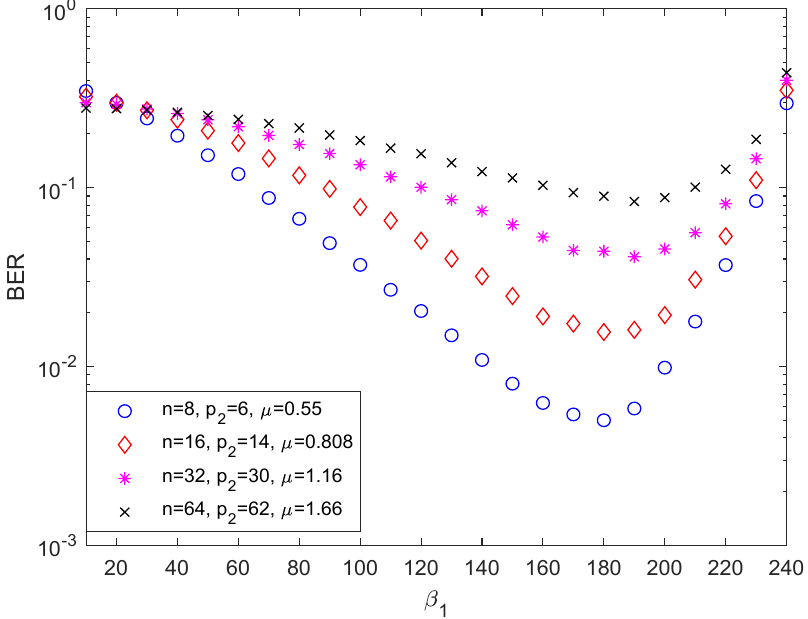
Figure 3. BER performance of GCI-DCSK SWIPT changes along with β 1 over AWGN channel with P s / N 0 = 18